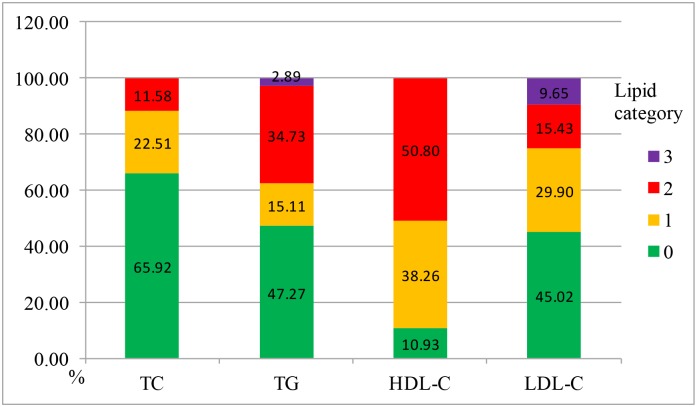
The lipid categories of dialysis patients according to the criteria in ATP III guideline.Note: Lipid categories according to ATP III: TC, total cholesterol: 0: optimal, <200 mg/dl; 1: borderline high, 200–239 mg/dl; 2: high, ≥240 mg/dl. TG, Triglycerides: 0: optimal, <150 mg/dl; 1: borderline high, 150–199 mg/dl; 2: high, 200–499 mg/dl; 3: very high, ≥500 mg/dl. LDL-C, low density lipoprotein cholesterol: 0: optimal, <100 mg/dl; 1: near optimal, 100–129 mg/dl; 2: borderline high, 130–159 mg/dl; 3: high or very high, ≥160 mg/dl. HDL-C, high density lipoprotein: 0: ≥ 60 mg/dl; 1: 40–60 mg/dl; 2: <40 mg/dl.Of all the patients, thirteen cases (4.18%) were taking statin drugs, and only one patient was taking fenofibrate.